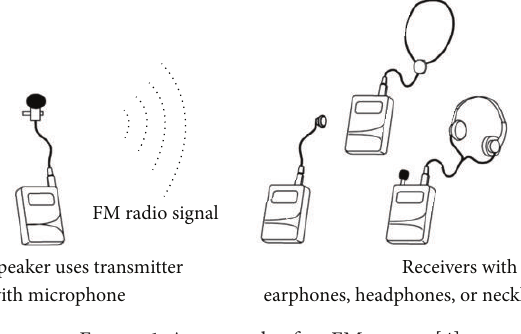
Figure 1: An example of an FM system